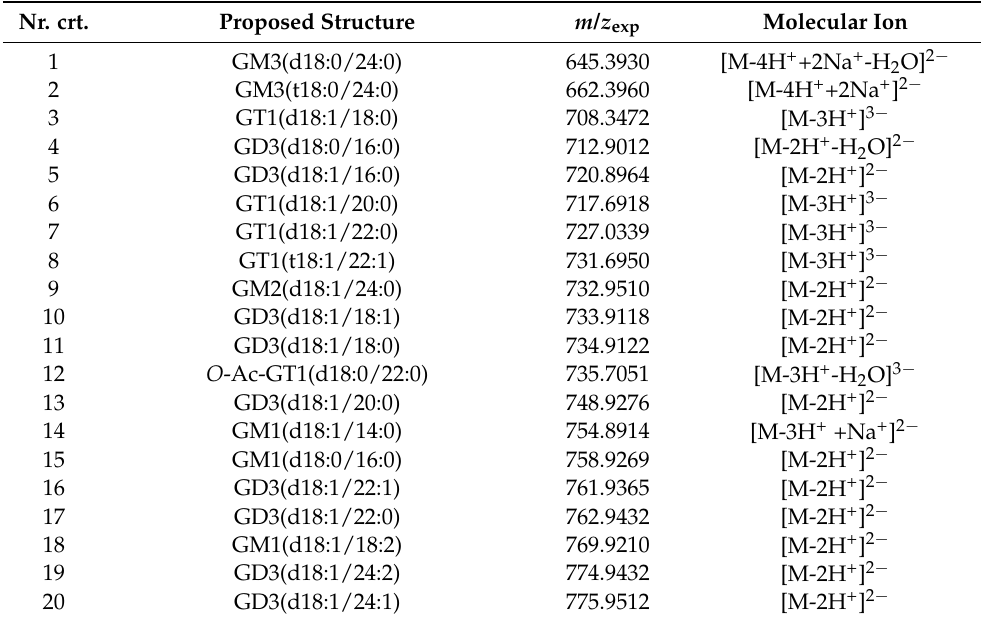
Table 3. Assignment of the ions detected by (-)nanoESI Orbitrap MS in HE42 mixture (reprinted with permission from [171]).